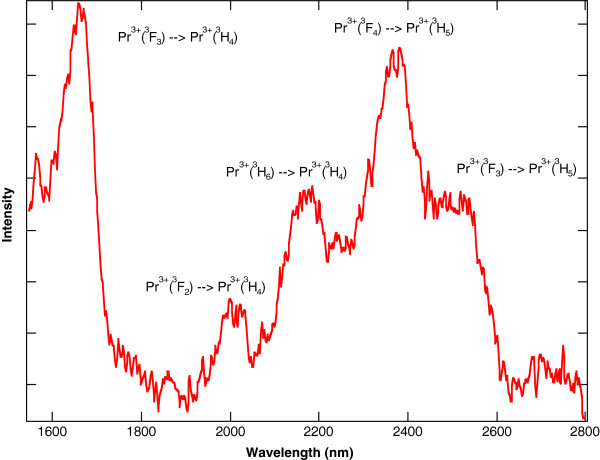
Fluorescence from 1,600 to 2,800 nm resulting from 1,483-nm pumping of Pr3+:KPb2Cl5. The sample has a Pr3+ concentration of 1.5 × 1020 ions/cm3.